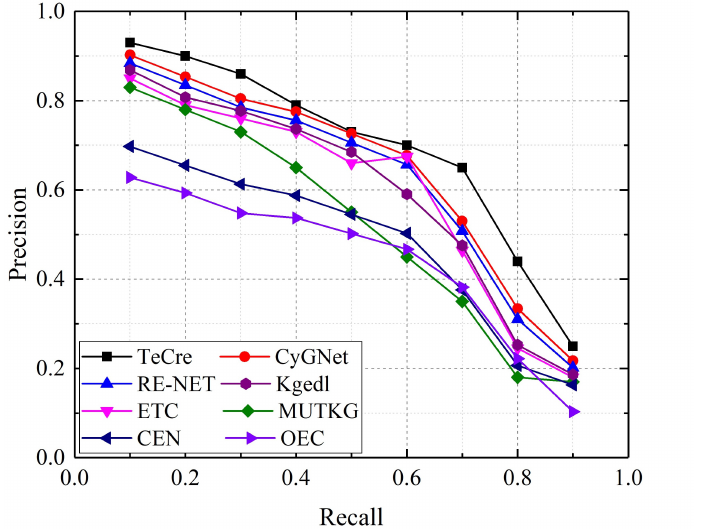
Figure 3. The recall accuracy curve of TeCre and the baseline method on the YAGO15K